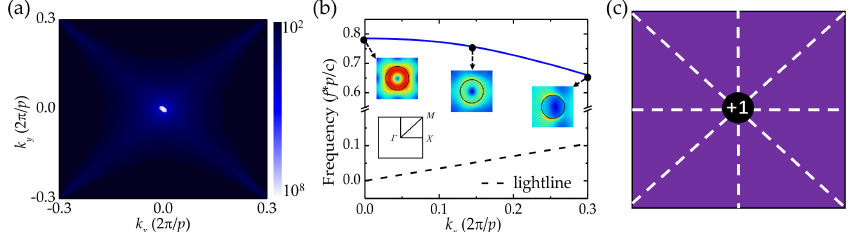
Figure 2. ( a ) The distribution of Q factor in momentum space for the LiNbO 3 cylinder. The symmetric cylinder: h = 400 nm, r = 333 nm. ( b ) The band structure of the cylinder array. Inset: the distributions of the electric field. ( c ) The corresponding topological charge of the polarization vortices located at the Γ